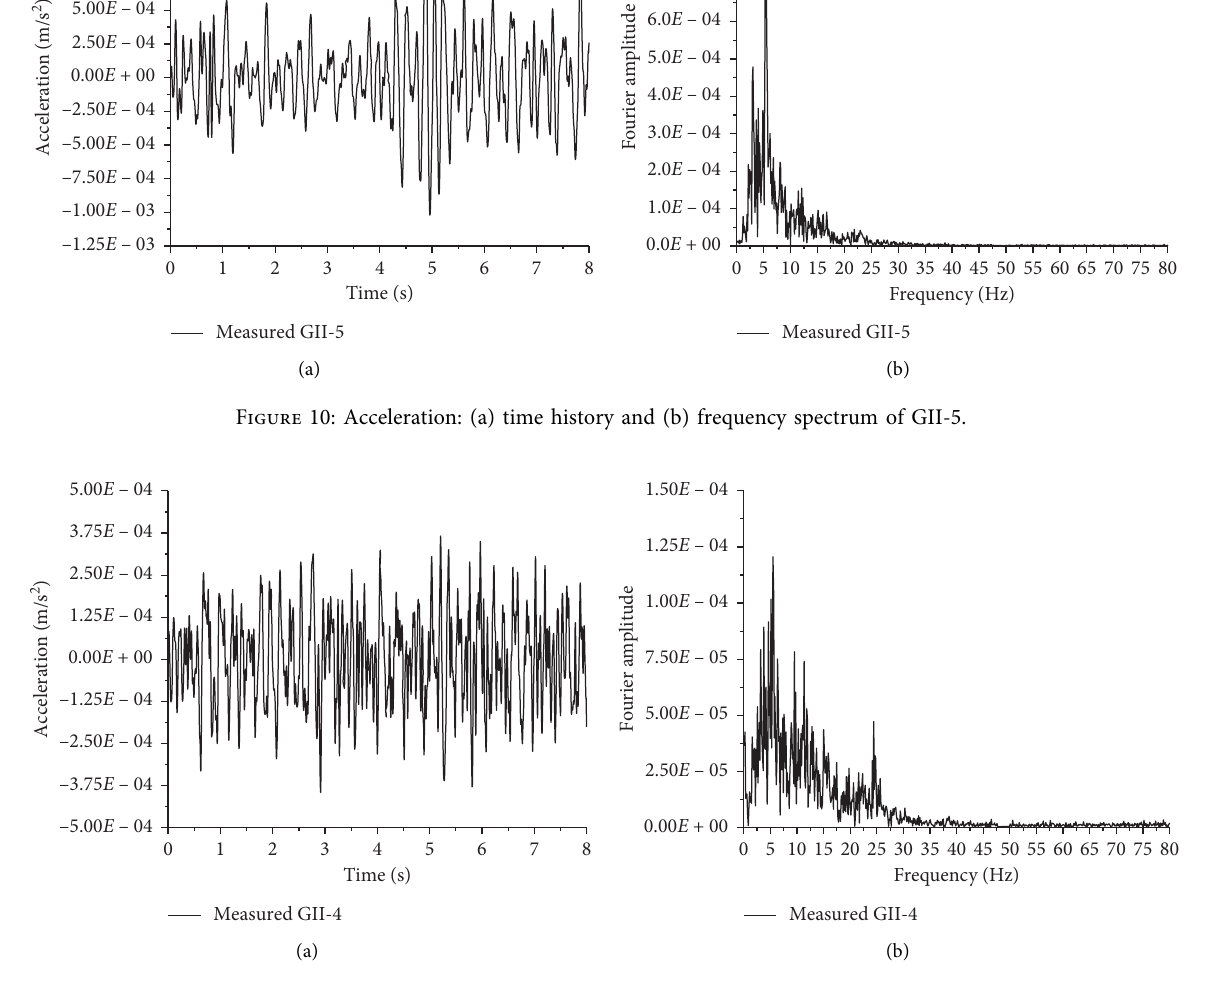
Figure 11: Acceleration: (a) time history and (b) frequency spectrum of GII-4.